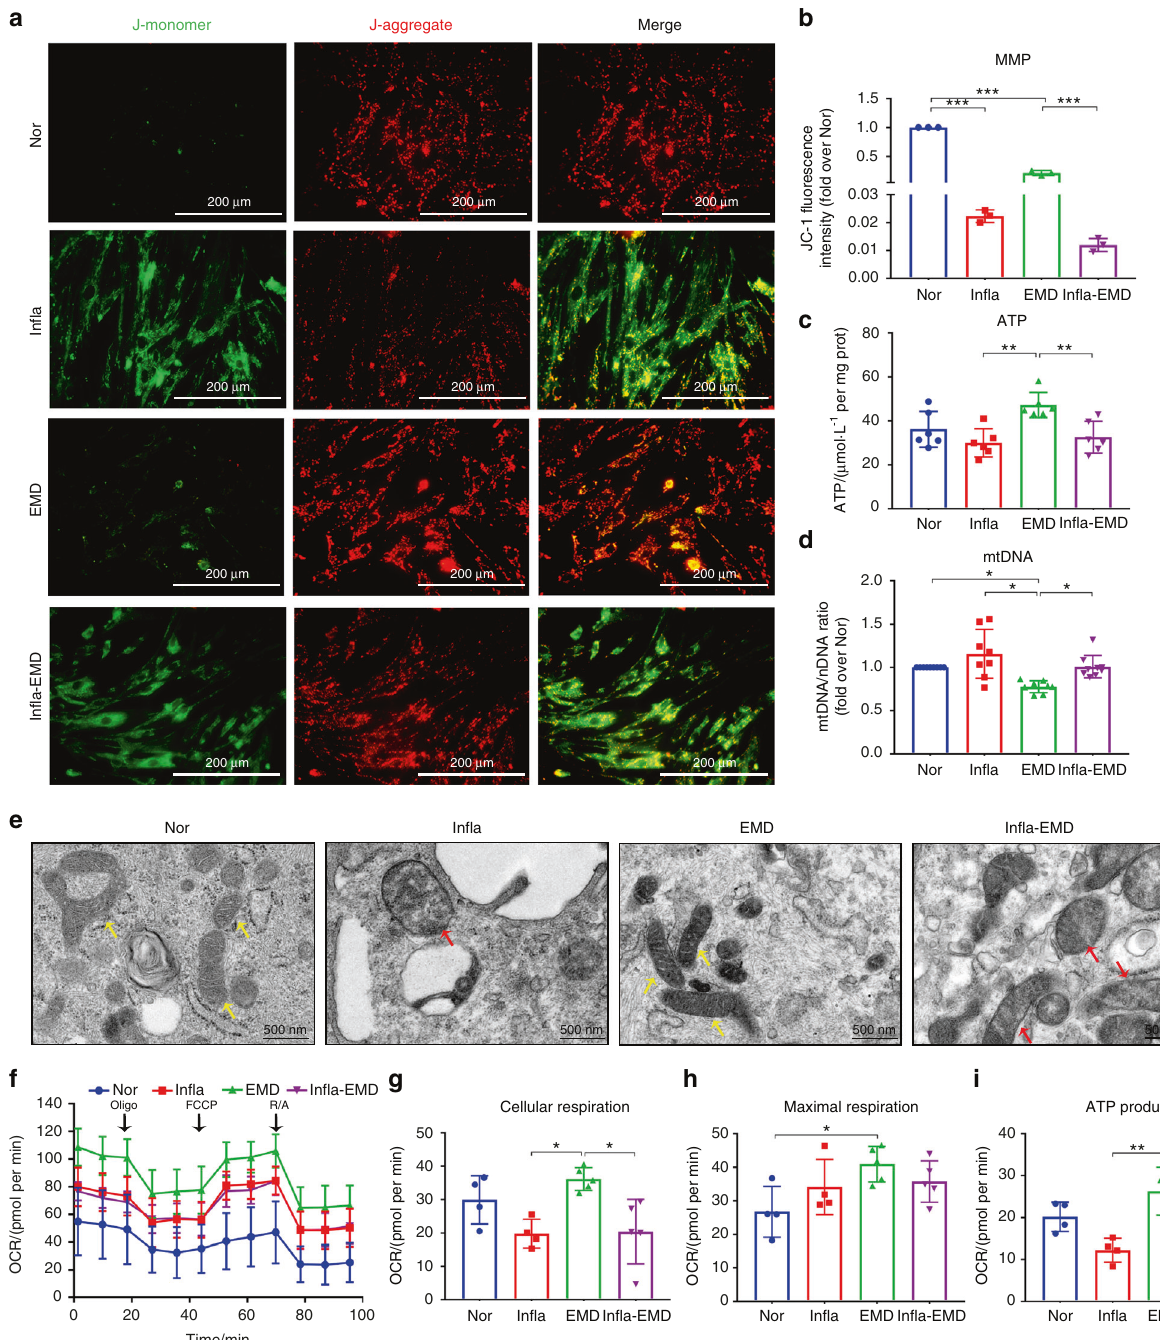
Fig. 2 In fl ammatory cytokines cause mitochondrial dysfunction in PDLSCs during cementoblastic differentiation. The cells were incubated in normal α -MEM (Nor), medium with the in fl ammatory cytokines TNF- α and IL-1 β (In fl a), medium with the cementoblastic inducer EMD (EMD), or medium with both in fl ammatory cytokines and EMD (In fl a-EMD). a The MMP was determined using a JC-1 probe (immuno fl uorescence staining; scale bar: 200 μ m). b Quanti fi cation of the MMP (re fl ected by the relative ratio of red/green fl uorescence intensity of JC-1). c Intracellular ATP contents determined by ATP assays. d mtDNA content determined by qRT-PCR. e Morphometric analysis of mitochondria by transmission electron microscopy (yellow arrows indicate healthy mitochondria, red arrows indicate swollen mitochondria; scale bar: 500 nm). f The OCR of PDLSCs determined using a Seahorse Bioscience XF Analyzer; arrows indicate the sequential injection of the ATPase inhibitor Oligo (1 μ mol·L − 1 ), the uncoupling reagent carbonyl cyanide-p- tri fl uoromethoxyphenylhydrazone (FCCP, 1 μ mol·L − 1 ) and inhibitors of the electron transport chain rotenone/antimycin (R/A, 2 μ mol·L − 1 ). g Quanti fi cation of maximal respiration (differences between the maximum rate measurement after FCCP injection and the minimum rate measurement after R/A injection). h Quanti fi cation of cellular respiration (basic OCR value prior to Oligo injection). i Quanti fi cation of ATP production (difference between fi nal rate measurement prior to Oligo injection and minimum rate measurement after Oligo injection). The data are shown as the mean ± SD for n from 3 to 8; * P < 0.05, ** P < 0.01 and *** P < 0.001 indicate signi fi cant differences between the indicated